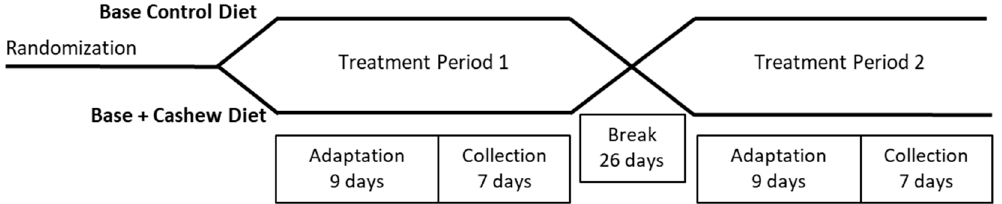
Figure 1. Study schematic indicating treatment periods, crossover design, adaptation of the diet and excreta collection periods.